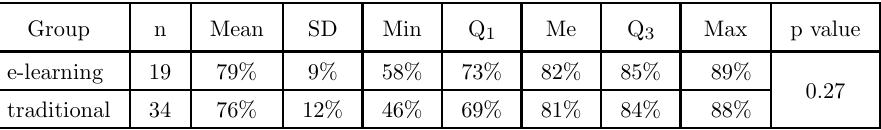
Table 4. Final results (%) of the subject “Selected issues of visual rehabilitation” Group n Mean e-learning